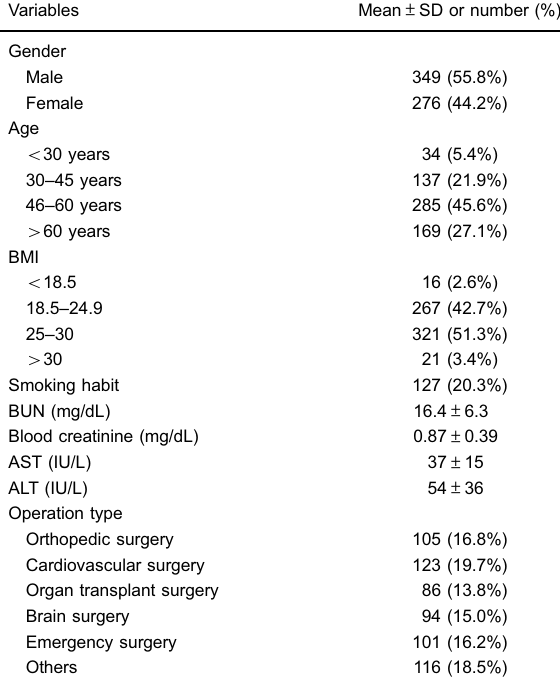
Table 1. Characteristics of study